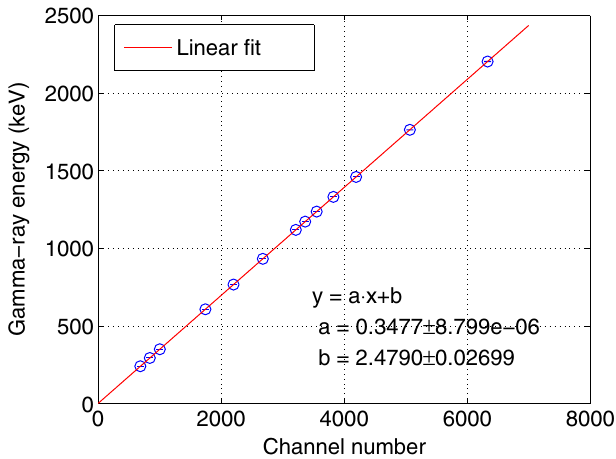
FIG. 9. (Color) The calibration curve of the HPGe detector. The straight line is a linear fit of the peak energies of the calibration sources.